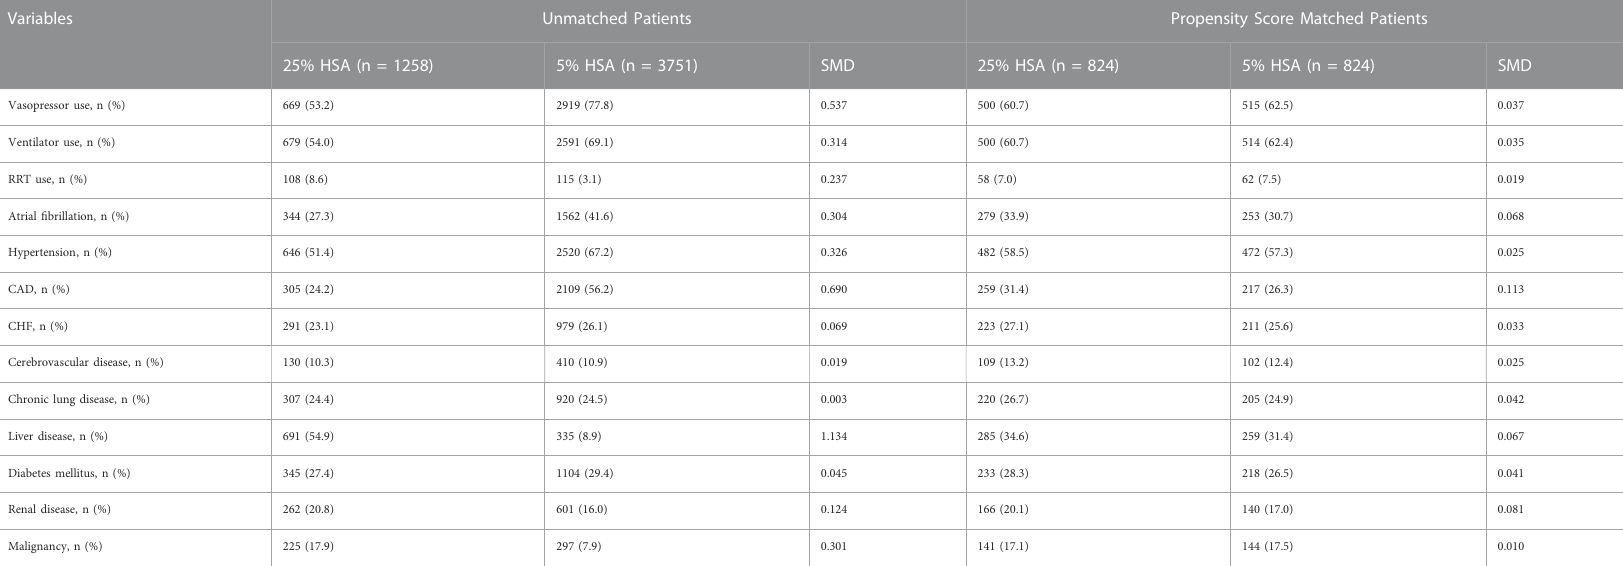
TABLE 1 ( Continued ) Demographics and baseline characteristics of patients before and after propensity score